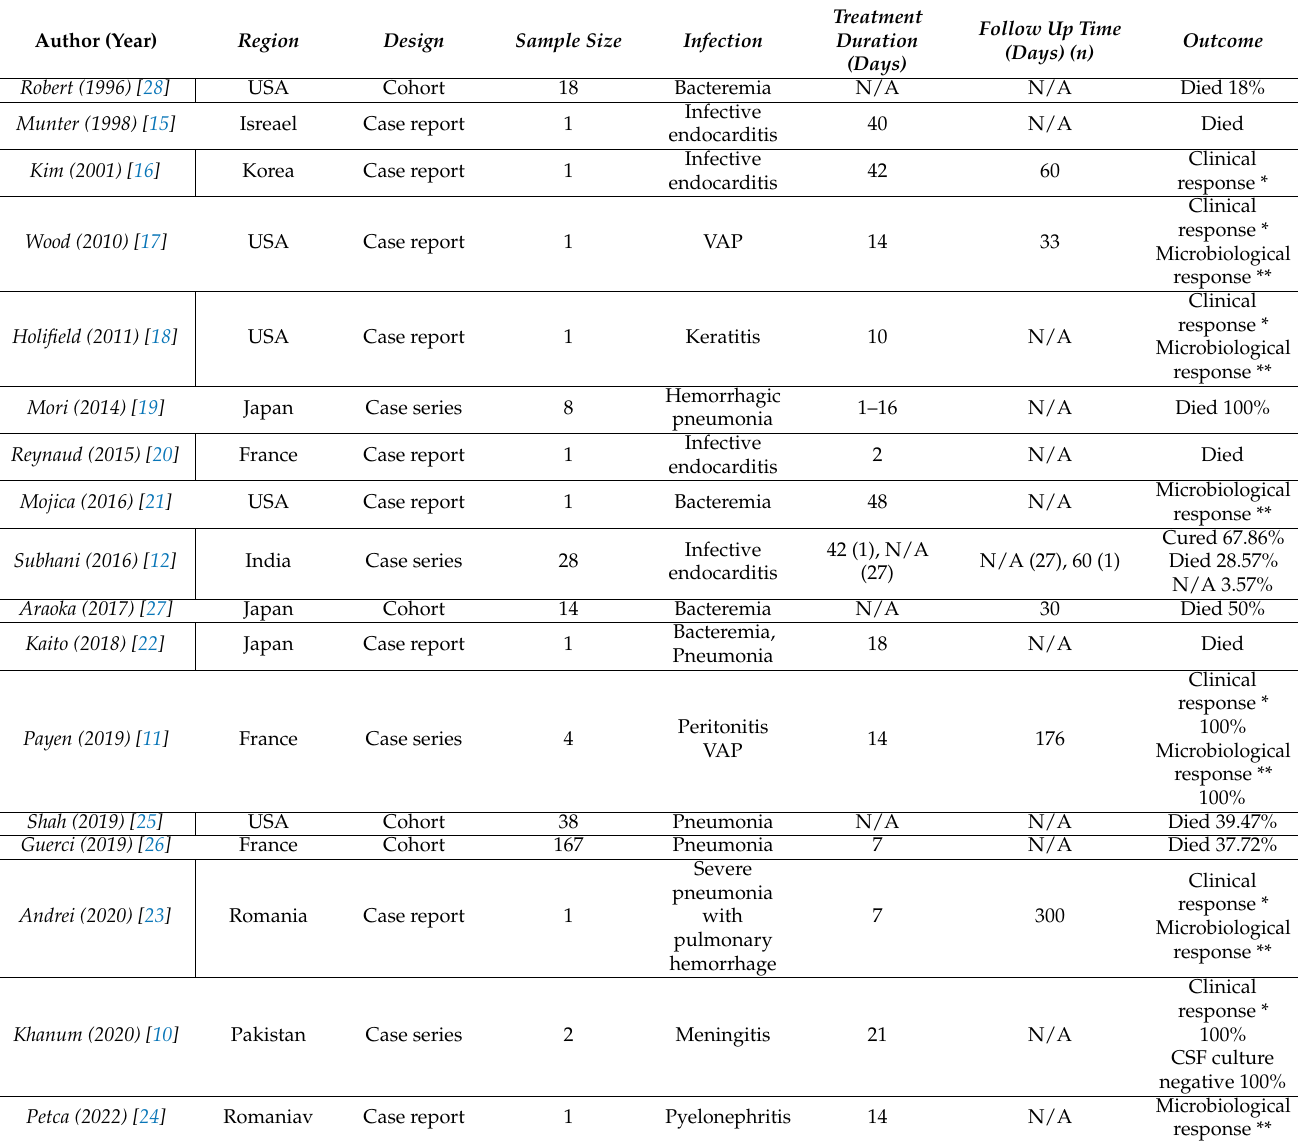
Table 1. Study characteristics of included studies of combination treatment of S. maltophilia